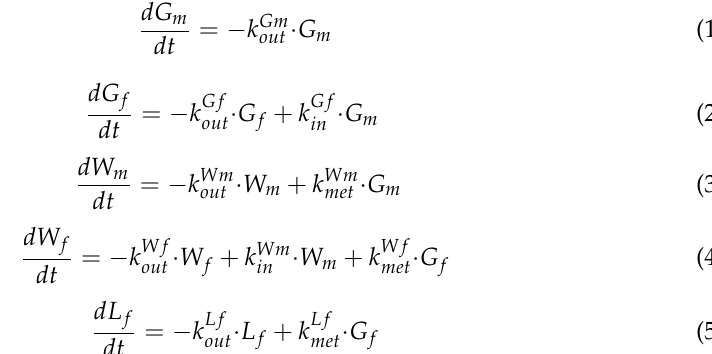
focus on glucose, water or lactate signals averaged over the entire time course of the experiment, i.e., if 10 images were taken over a 125 min experiment, what is shown are the sum of the corresponding peak images as mapped for each organ, divided by 10. ( A ) Average signals normalized according to the image intensity observed in each organ for the pre-injection 2 H-water peak, for the control and l-NAME-treated animals. This gives an idea of the maximum absolute levels reached by each metabolite in each organ. ( B ) Idem as ( A ) but upon normalizing the water and lactate 2 H images by the maximum 2 H 6,6 (cid:48) -glucose signal observed in the animals’ organs. This conveys an idea of glycolytic activity, independent of the glucose injection details. Error bars indicate standard deviations of the measurements for the indicated regions; notice that because of limited spatial resolution, all the fetal organs (brain, liver, heart) are here pooled in the “fetus” category. Indicated as well are p -values calculated from paired, two sample t -tests assuming unequal variances, distinguishing uptake/activity in control vs. preeclamptic mice for the various metabolites; only significant differences ( p ≤ 0.05) are noted. ND: